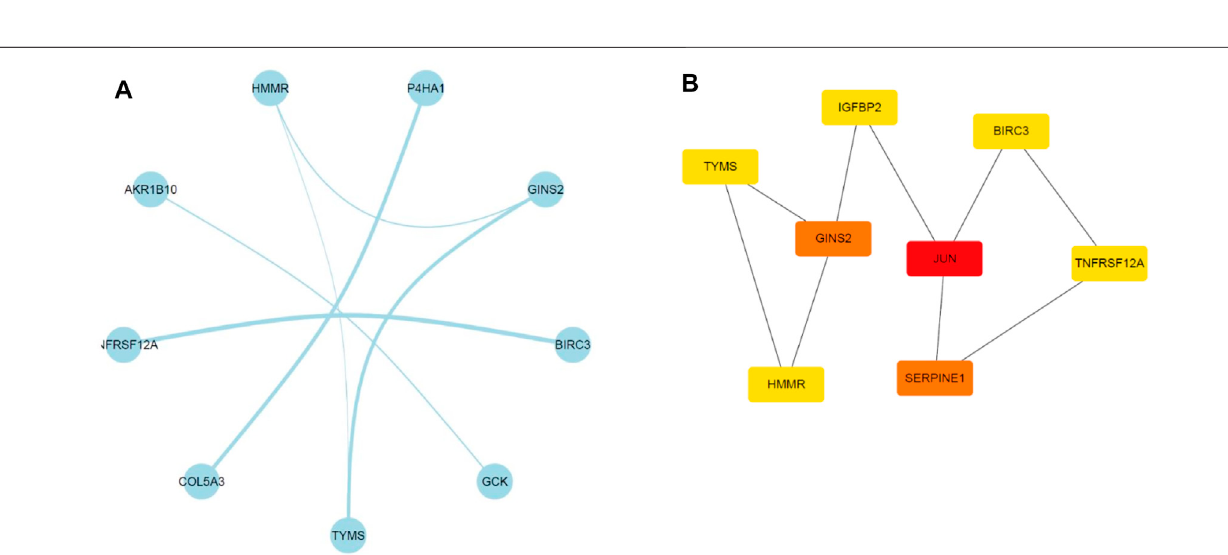
Frontiers in Genetics |